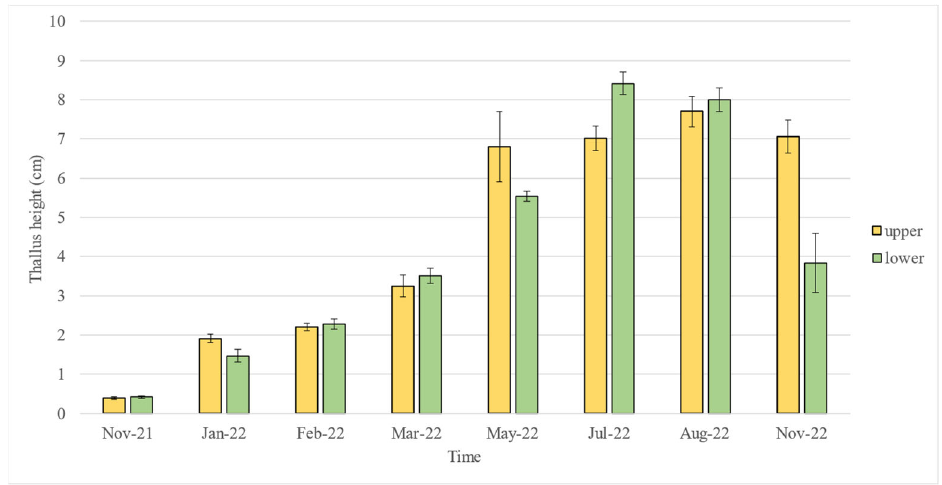
Figure 4. Growth of planted F. virsoides over a one-year period. Each measurement represents an average of 10 measured thalli. Data are presented as mean ± SE. Colours represent upper (yellow) and lower (green) positions for plots.